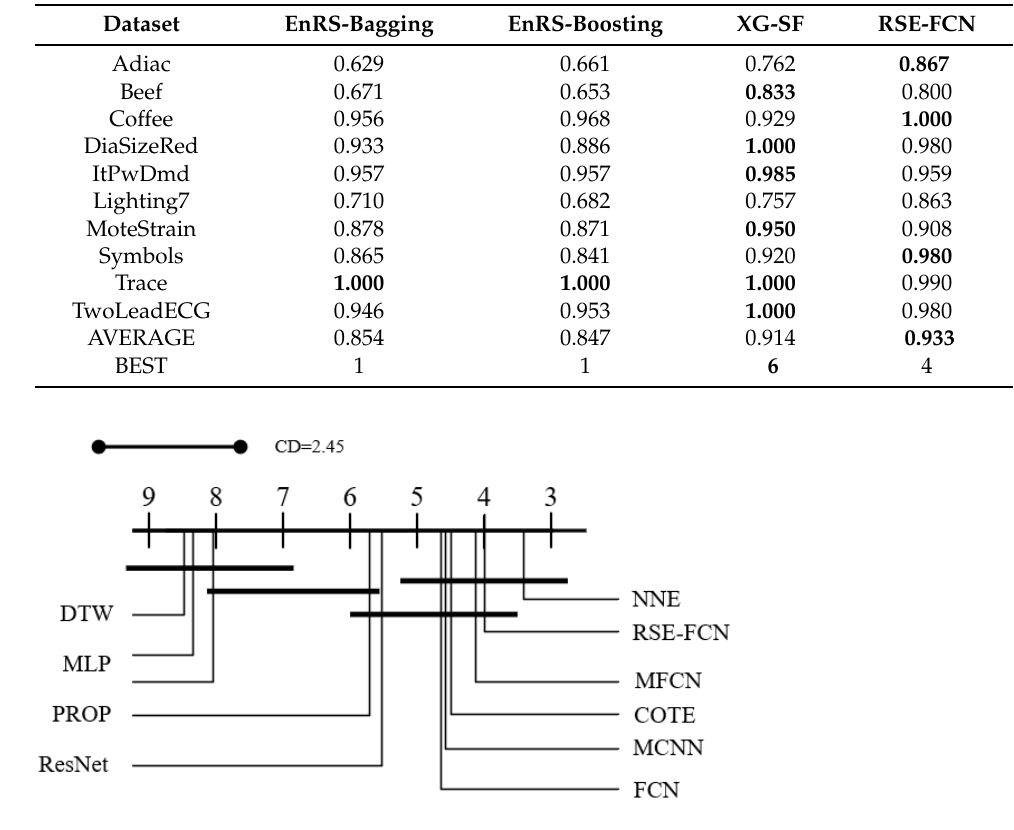
Figure 4. Critical difference diagram of models involved in